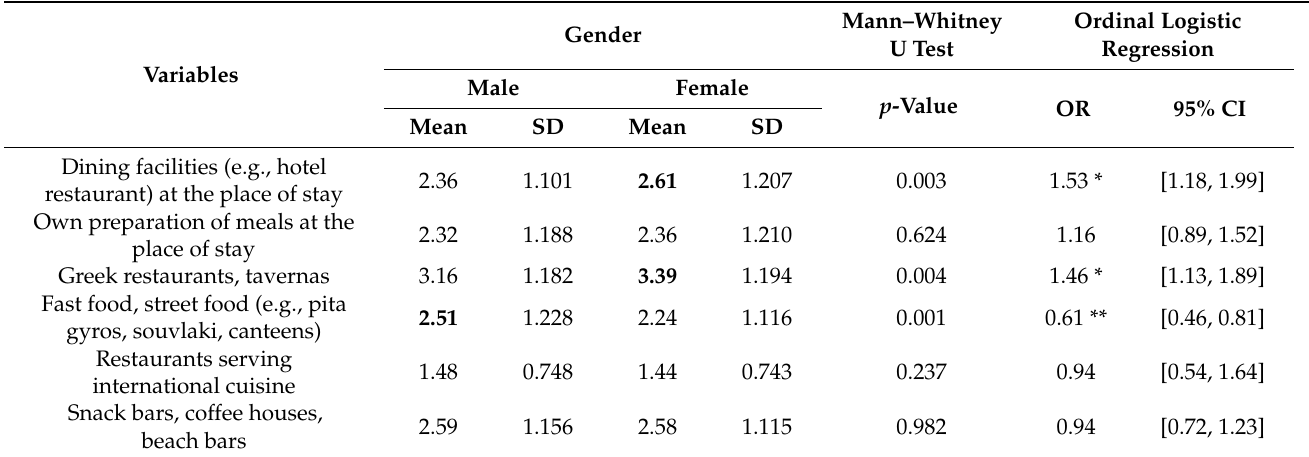
Table 4. Types of dining facilities used by tourists.